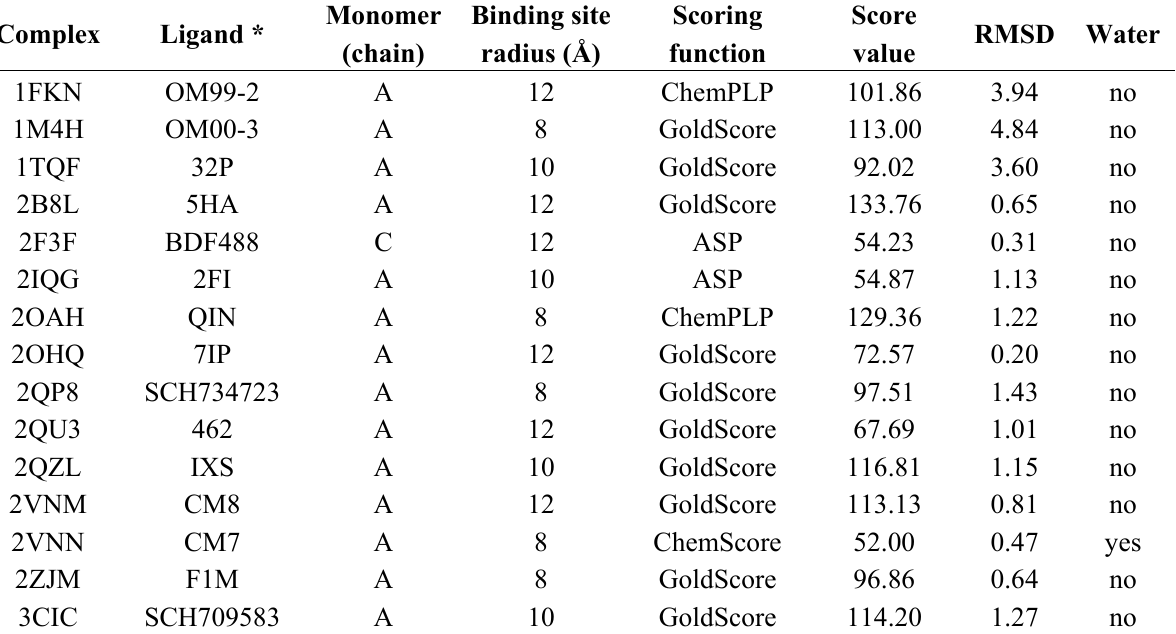
Table 1. Optimal settings of Gold for redockings of 20 reference